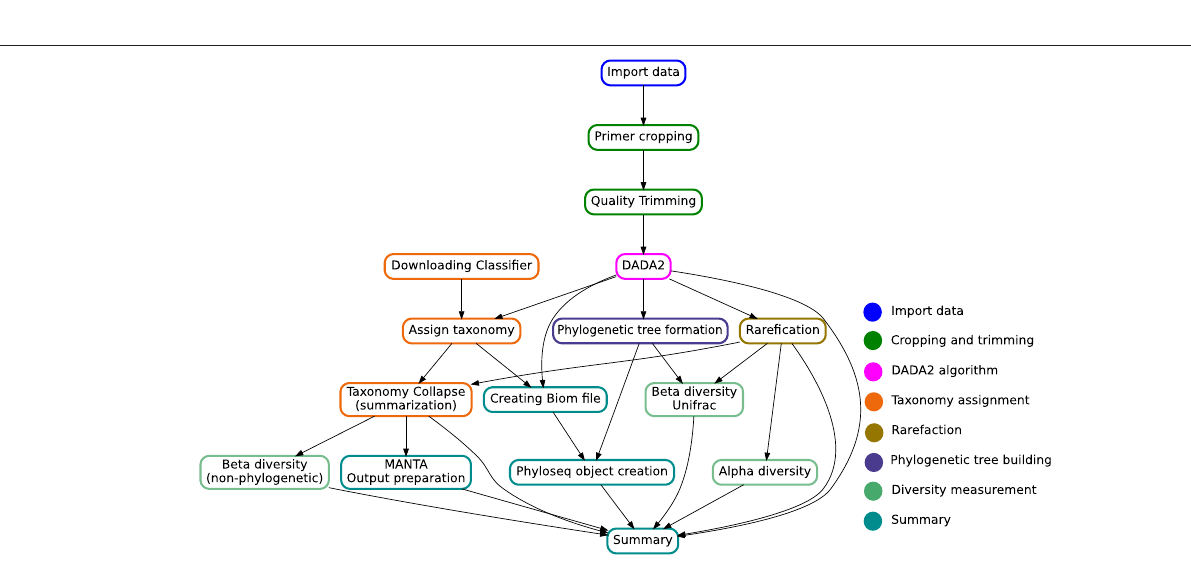
FIGURE2| DirectedAcyclicGraphshowingthekeystepsintheSnaqpipeline.Noticethatthegiventarget fi lewilldetermine aspeci fi ctraversalofthegraph.Color of nodes is used to indicate the analysis stage, as proposed in the implementation